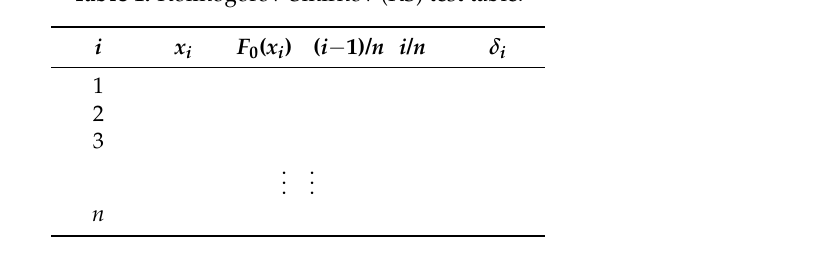
Table 1. Kolmogorov-Smirnov (KS) test